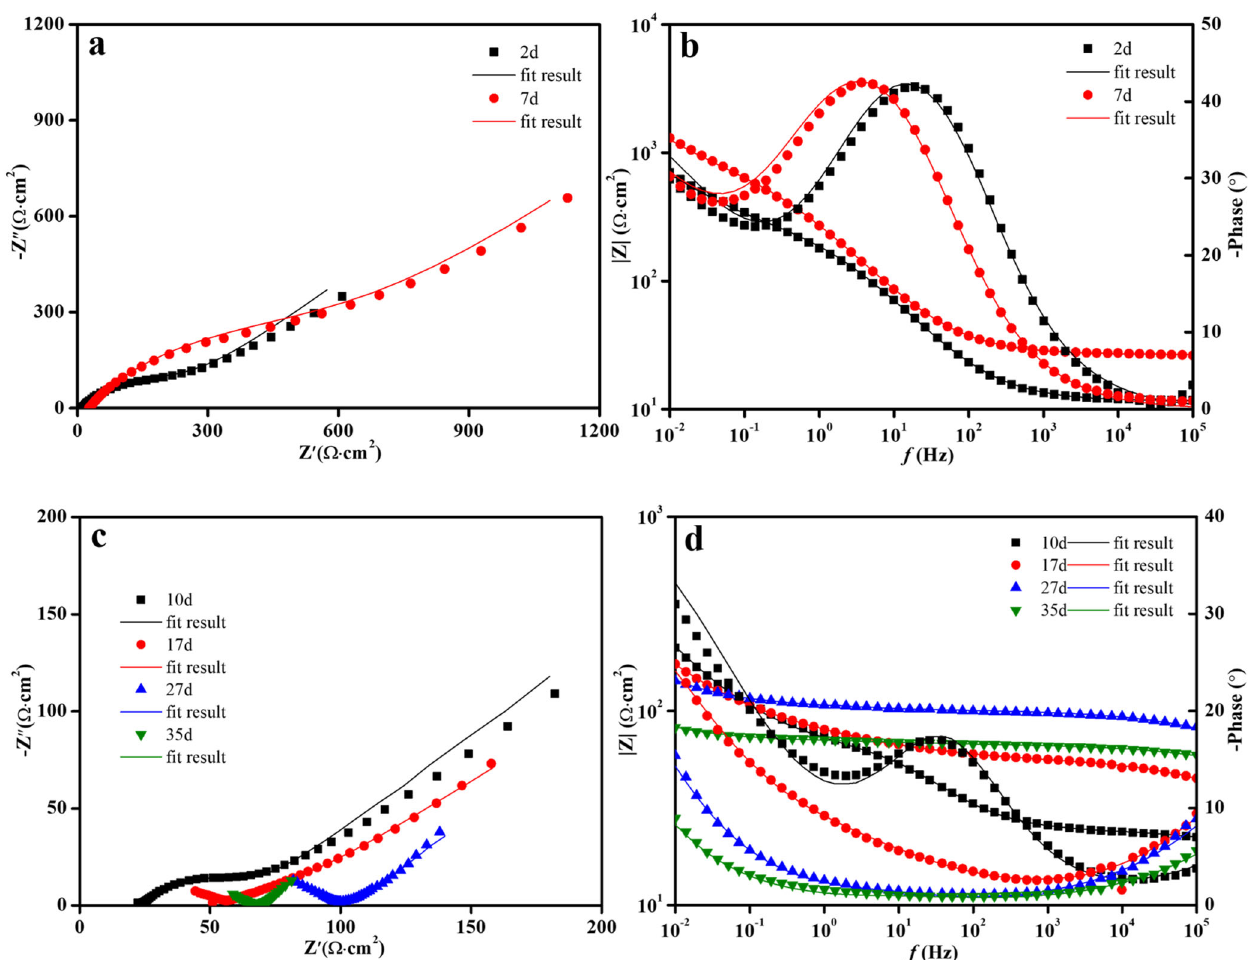
Fig. 8 EIS. Electrochemical impedance spectrum of 14-1# (the fi rst electrode in row 14 in the high-tide zone) with respect to time: a , c Nyquist plots and b , d Bode plots.